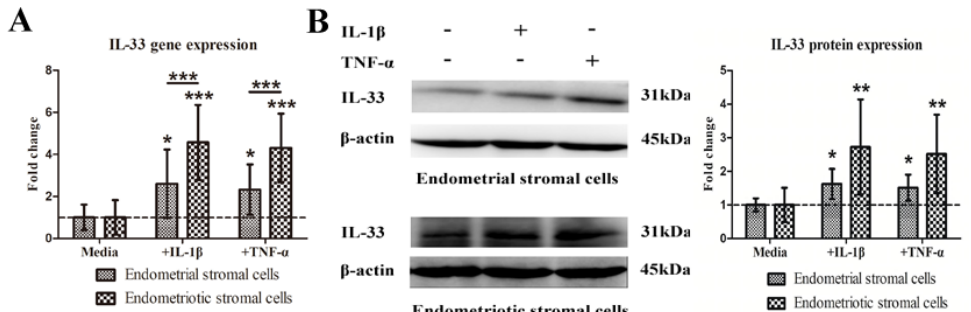
Figure 2. IL-1 β or TNF- α stimulates the expression of IL-33 by endometrial and endometriotic stromal cells. ( A ). Endometrial stromal cells (n = 8) and endometriotic stromal cells (n = 10) were stimulated with or without IL-1 β or TNF- α for 24 h, and quantitative PCR was used to measure IL-33 mRNA levels relative to GAPDH levels. The fold change relative to the amount in control endometrial stromal cells cultured in media is shown here. ( B ). Left panels: Detection of protein levels of IL-33 by immunoblotting of lysates of endometrial and endometriotic stromal cells treated with buffer, IL-1 β , or TNF- α . The grouping of blots from the same protein was not cropped, and all protein blots were from the same gel. Right panels: Relative fold change in protein levels of IL-33 in endometrial stromal cells (n = 6) or endometriotic stromal cells (n = 7) treated with indicated con- ditions. *: p < 0.05; **: p < 0.01; ***: p < 0.001. Data are presented in means ± SDs.